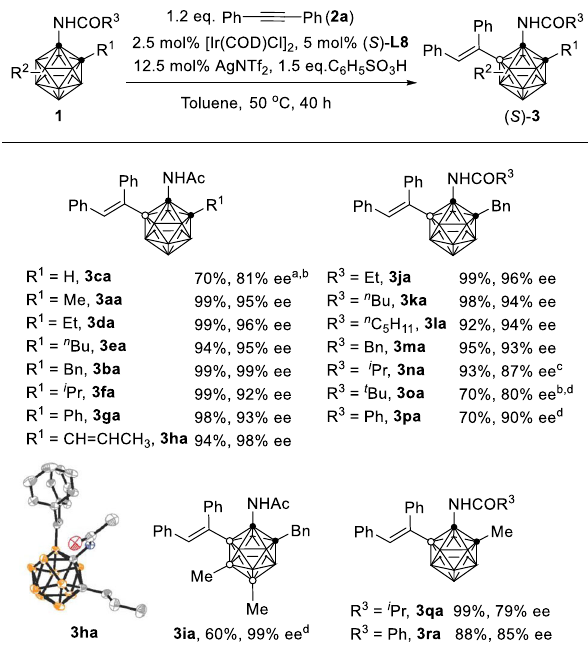
Fig. 4 o -Carborane substrates scope and molecular structure of ( S )-3ha.